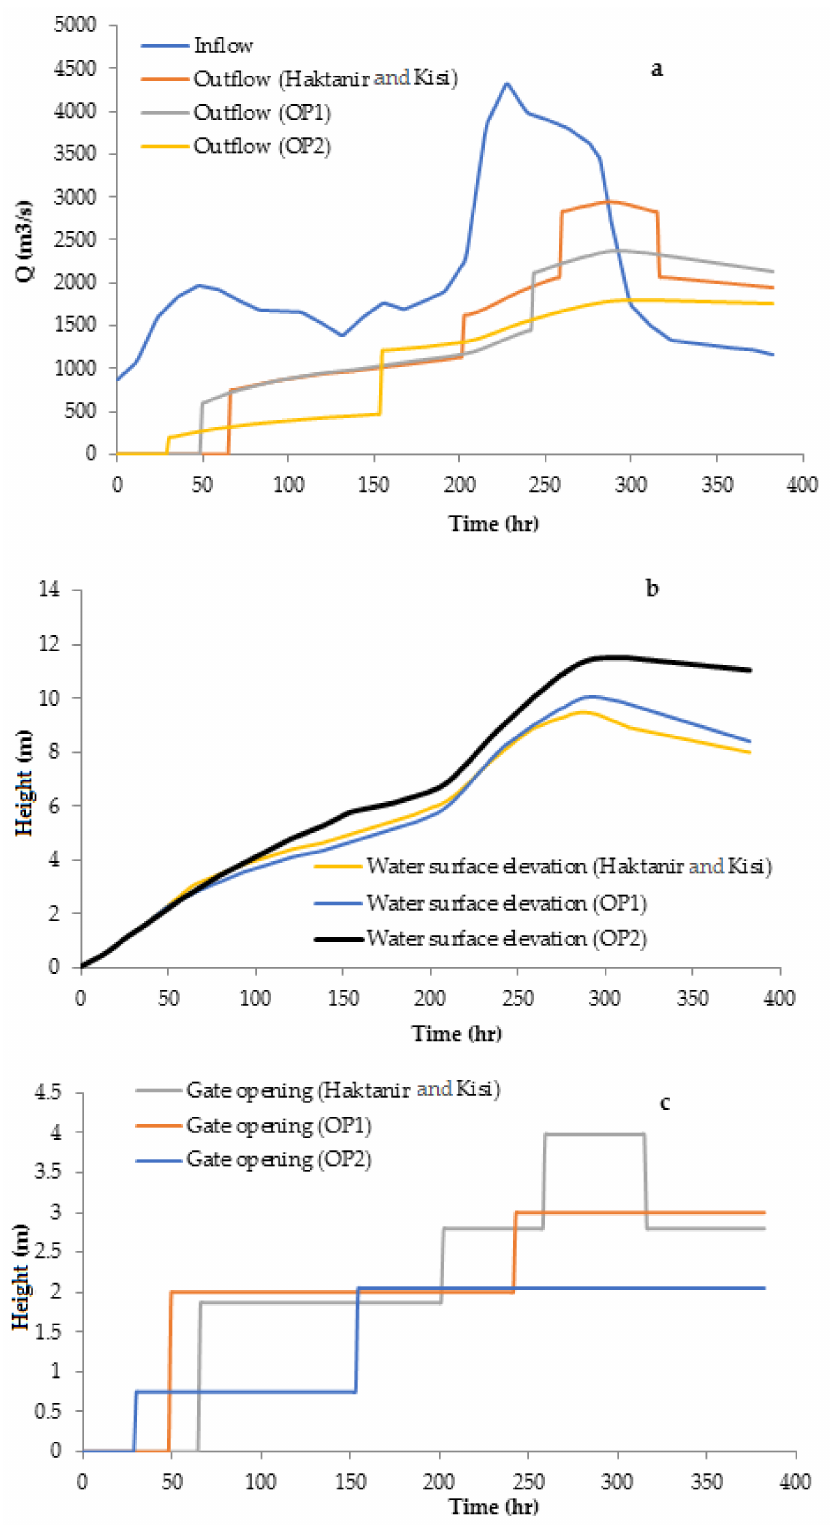
Figure 5. Application of both approaches—flood hydrograph (50-year): ( a ) inflow and outflow hydrographs; ( b ) water surface elevation; ( c ) gate opening ( n =